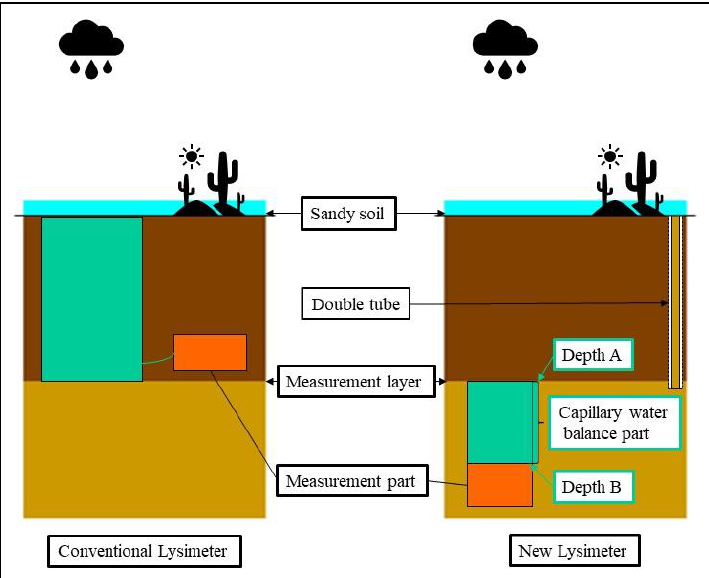
Figure 2. Design of the new lysimeter and experimental plot design .